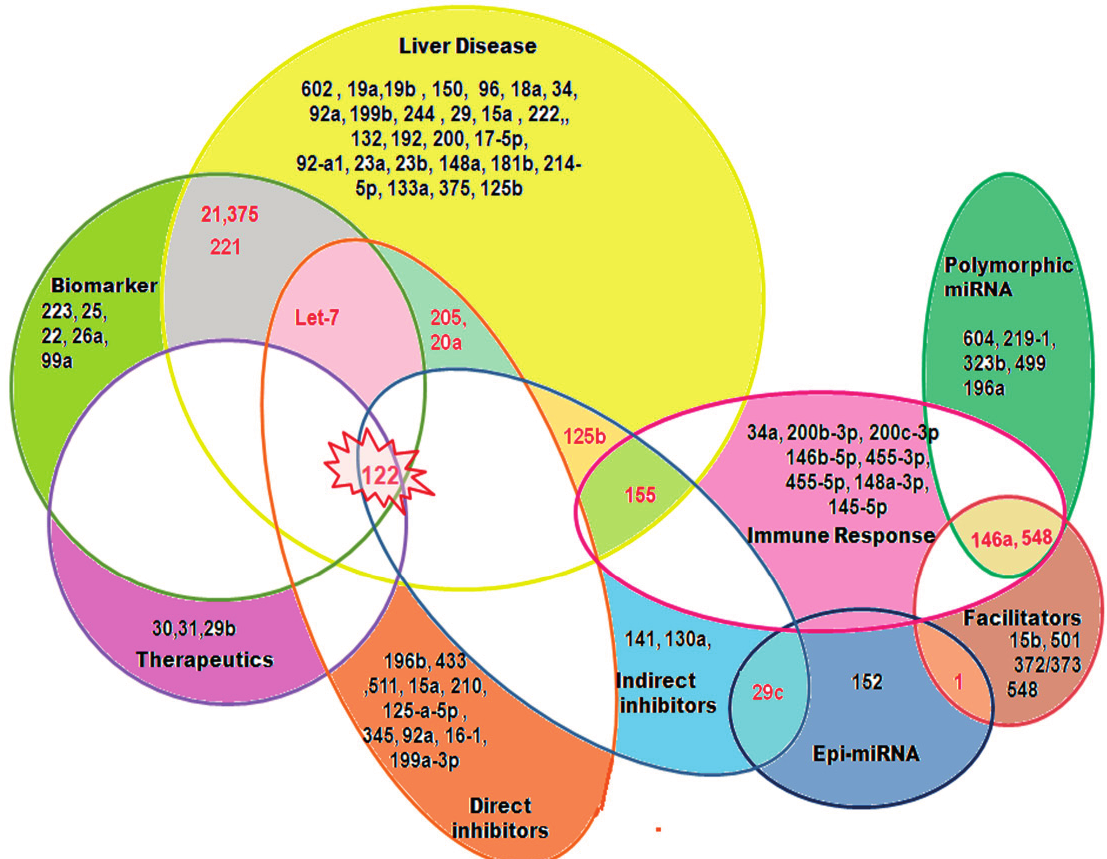
Figure 2. An overview of specific miRNAs associated with different aspects of hepatitis B virus biology. miRNAs are designated by numbers in the Venn diagram. Those marked in red color indicate miRNAs that are associated with multiple aspects of HBV biology as depicted, while the ones marked in black indicate those miRNAs that are associated with a single